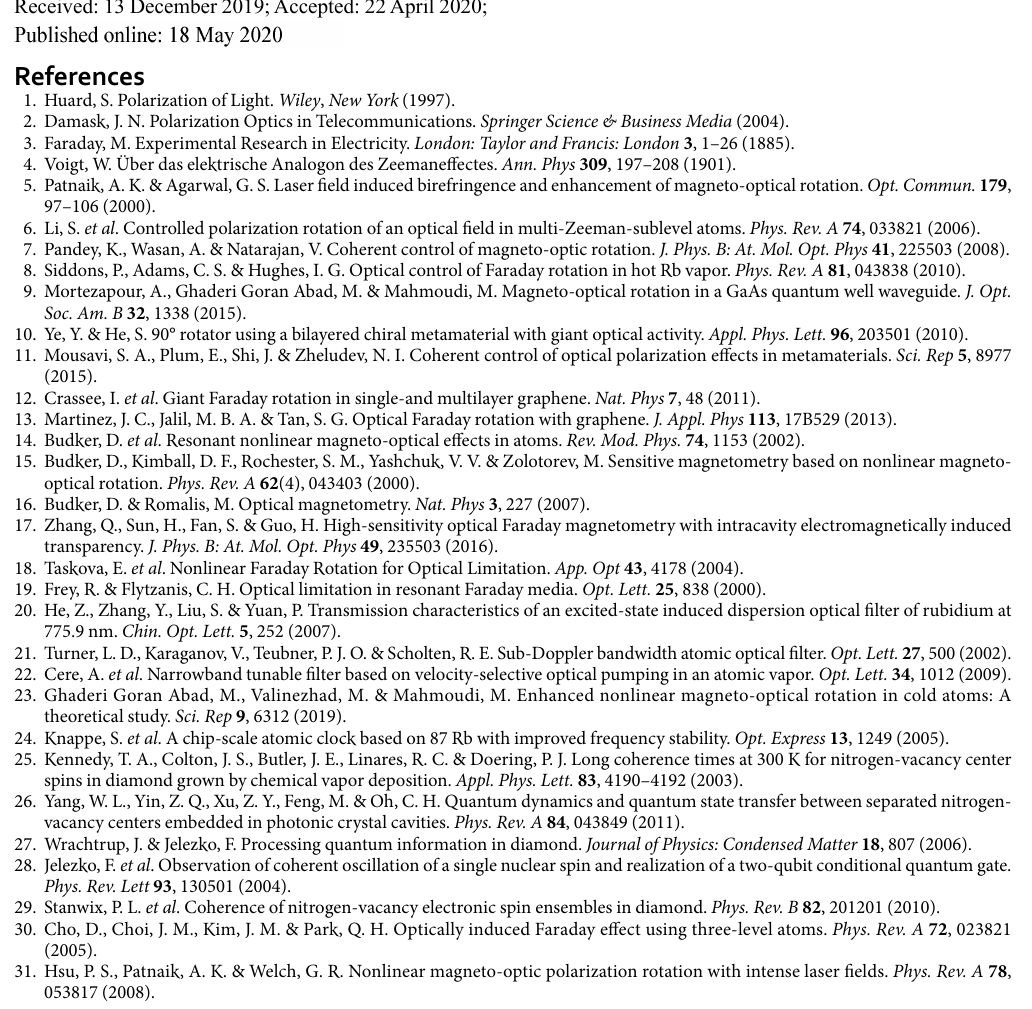
relative phase of the applied fields. The physical mechanism was explained using the analytical expressions. Our scheme can be used as a polarization converter for efficient switching TE/TM modes in optical communications, polarization spectroscopy, the depolarization backscattering lidar and precision measurements.